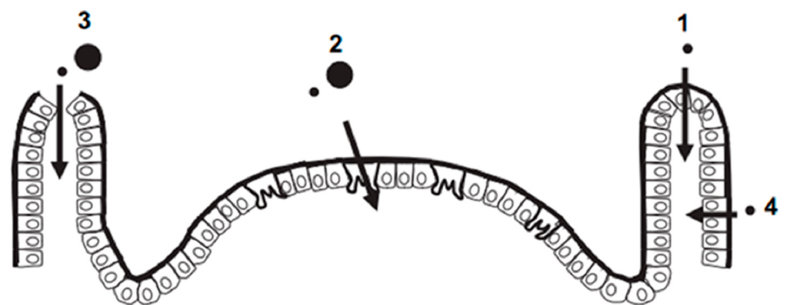
Figure 1. Particles crossing the gastrointestinal tract. 1. Small NPs (<50–100 nm) cross the ‘regular’ epithelial cells by endocytosis. 2. Large NPs and small microparticles cross the M-cell by transcytosis. 3. Feasible passage through villous ‘gaps’ of nano and microparticles. 4. Paracellular uptake of small NPs. Reprinted from reference [89]. Copyright (2010), with permission from Elsevier.